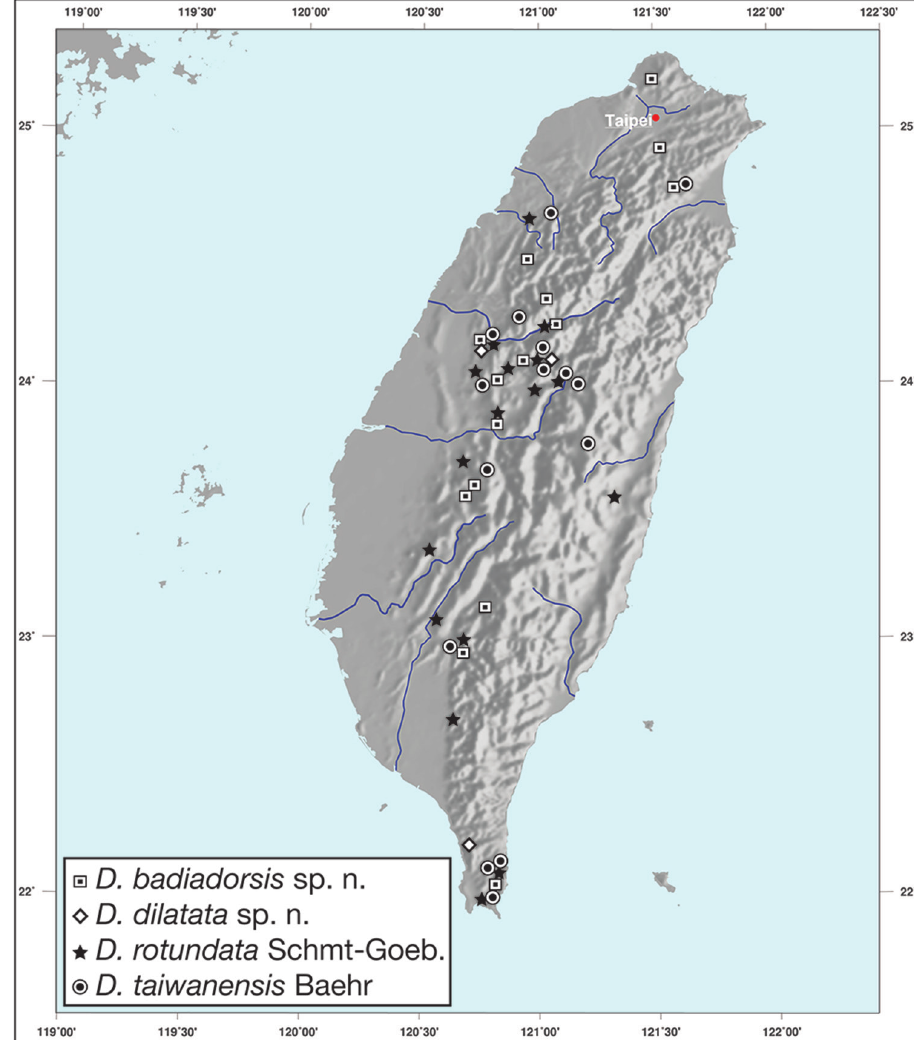
Figure 72. Map showing known localities for species of the genus Dolichoctis Schmidt-Goebel, in